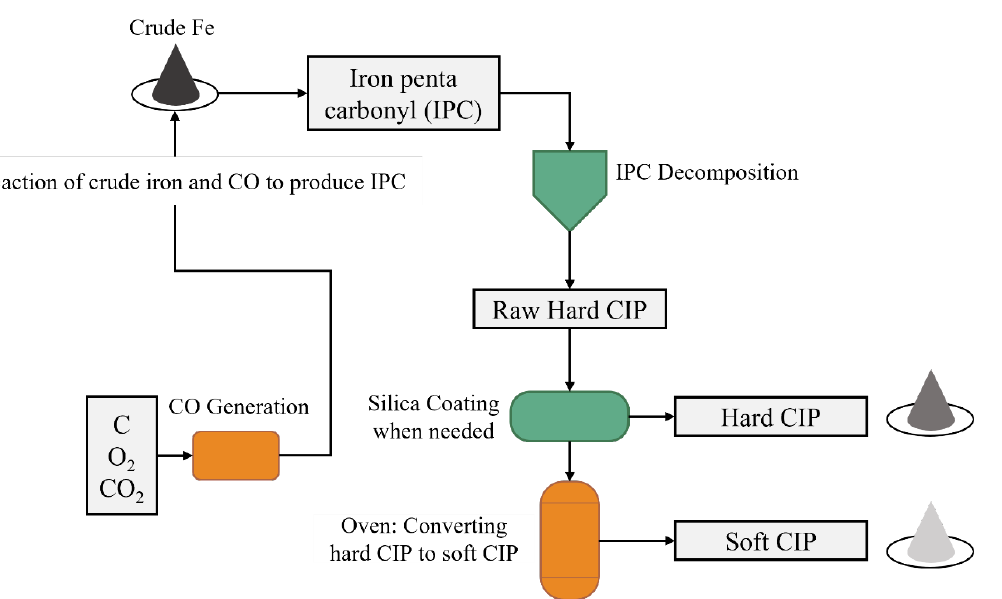
Figure 1. Production technique of soft and hard carbonyl iron particles. Table 2. Material properties of the carbonyl iron particles.